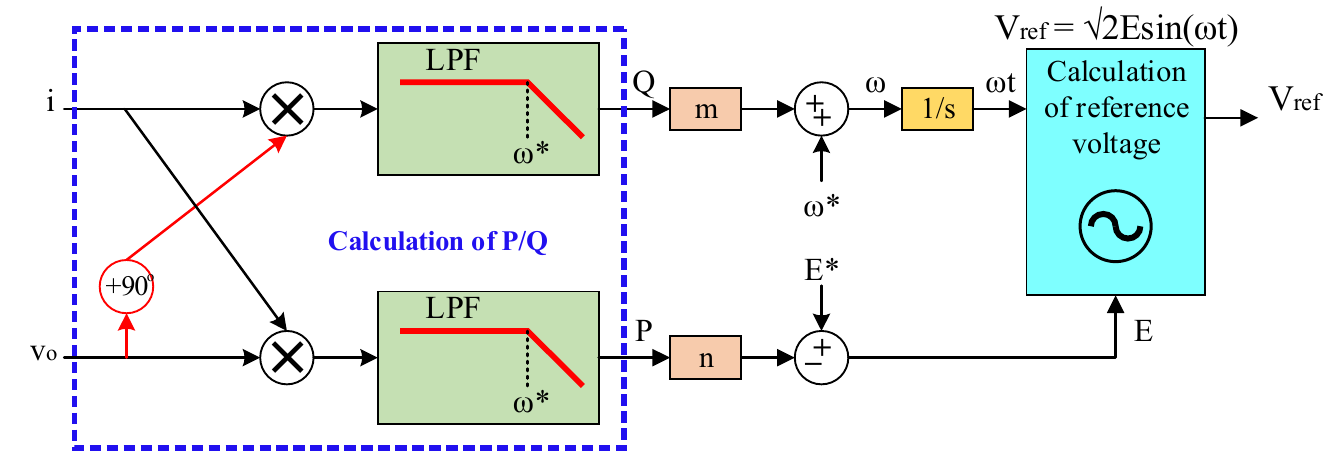
v r2 Figure 6. Equivalent circuit of two inverters connected to the grid. 𝑣 (cid:3045)(cid:2869) = √2𝐸 (cid:2869) 𝑠𝑖𝑛(cid:4666)𝜔 (cid:2869) 𝑡 + 𝛿 (cid:2869) (cid:4667), (10) 𝑣 (cid:3045)(cid:2870) = √2𝐸 (cid:2870) 𝑠𝑖𝑛(cid:4666)𝜔 (cid:2870) 𝑡 + 𝛿 (cid:2870) (cid:4667), (11) where E 1 and E 2 is the effective value of the source voltage. The load voltage is also calcu- lated from Equation (12). 𝑣 (cid:3042) = 𝑣 (cid:3045)(cid:2869) − 𝑅 (cid:3042)(cid:2869) 𝑖 (cid:2869) = 𝑣 (cid:3045)(cid:2870) − 𝑅 (cid:3042)(cid:2870) 𝑖 (cid:2870) . (12) According to Equation (12), the output voltage decreases with increasing load, caus- ing weak voltage regulation in the inverter-based DG output. According to Figure 6, the active and reactive power that each inverter injects into the load is calculated using Equa- tions (13) and (14). 𝑃 (cid:3036) = 𝐸 (cid:3036) 𝑉 (cid:3042) cos 𝛿 (cid:3036) − 𝑉 (cid:3042)(cid:2870) 𝑅 (cid:3042)(cid:3036) . (13) 𝑄 (cid:3036) = −𝐸𝑉 (cid:3042) 𝑅 (cid:3042) sin 𝛿 (cid:3036) . (14) As a result, the voltage and fundamental frequency droop characteristics for the case where the coupling impedance is predominantly resistive (Z 1 = R o1 and Z 2 = R o2 ) are ob- tained from Equations (15) and (16). Figure 7 shows the conventional droop controller. 𝐸 (cid:3036) = 𝐸 ∗ − 𝑛 (cid:3036) 𝑃 (cid:3036) ,